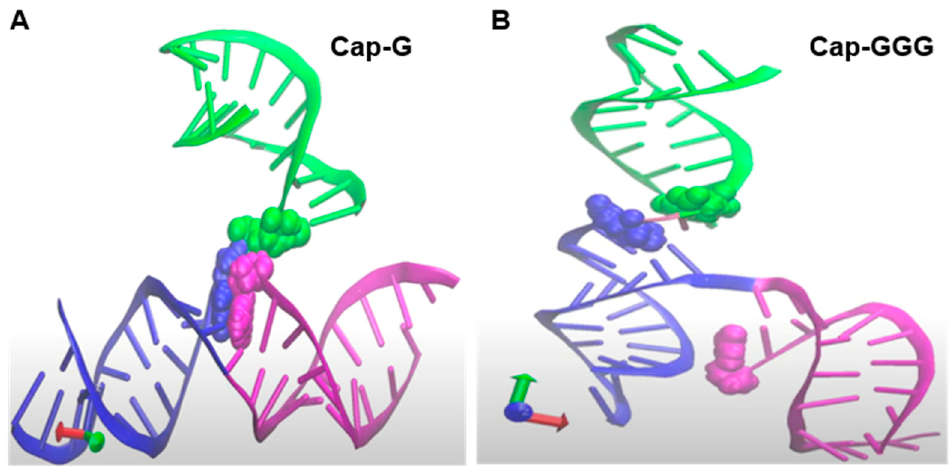
Figure 7. Predicted tertiary structure context of the HIV Capof the HIV NL4 − 3 5 ′ -UTR given transcription start site heterogeneity of one guanosine (G) or GGG. Zoom-in on the junction of TAR (magenta)-PolyA (blue)-U5 (green) helices. Cap, magenta atom; G104, blue atom and U105, green atom. ( A ) Cap-G at the 5 ′ terminus. ( B ) Cap-GGG at the 5 ′ terminus repositioned Cap ~ 26 Angstroms from the junction of PolyA-U5. Rotation of these structures is provided in Video S1.